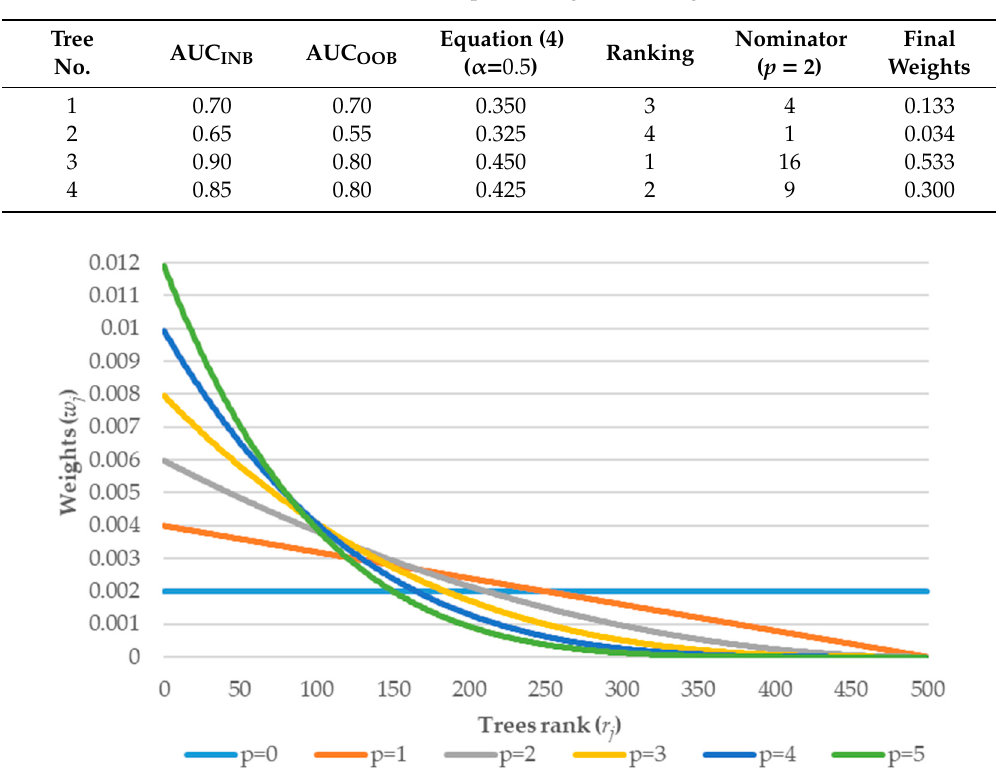
Table 3. An example of weights deriving.